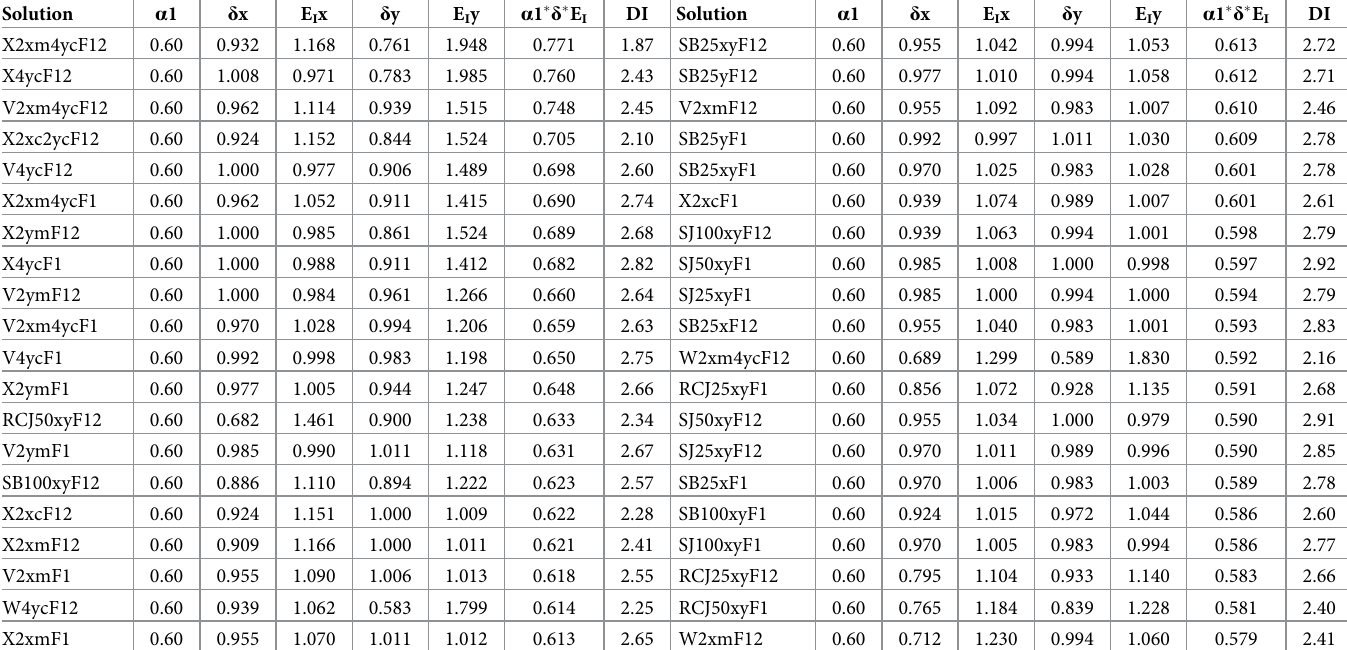
Table 2. The efficiency of each model.